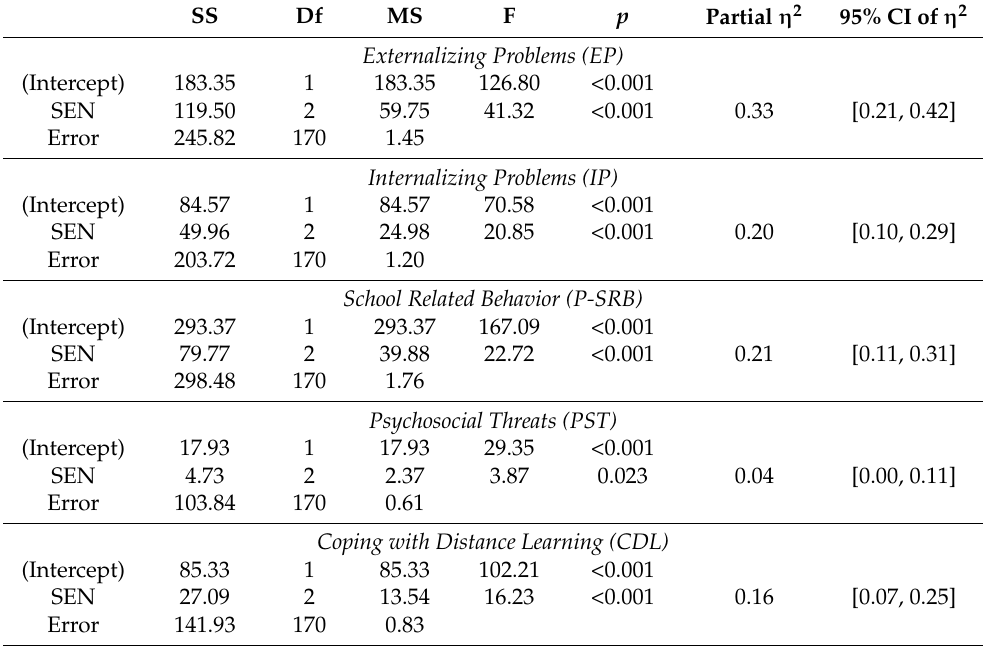
Table 4. ANOVA with current situation (EP, IP, P-SRB) and lockdown situation (PST, CDL) as